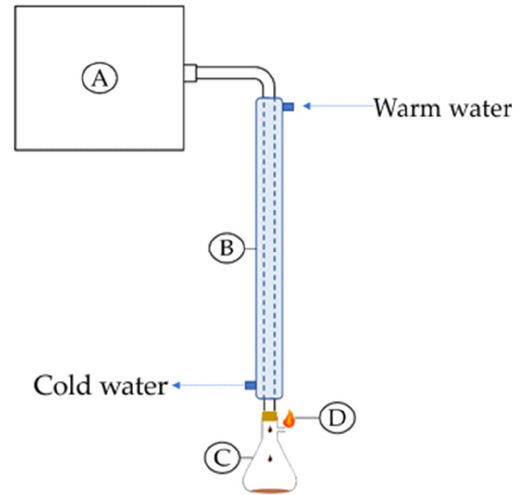
Figure 1. Schematic procedure of pyrolysis carried out in a muffle furnace. A: muffle furnace; B: condenser; C: collector of pyroligneous acid; and D: burning of non-condensable gases. Source: the authors (2021).